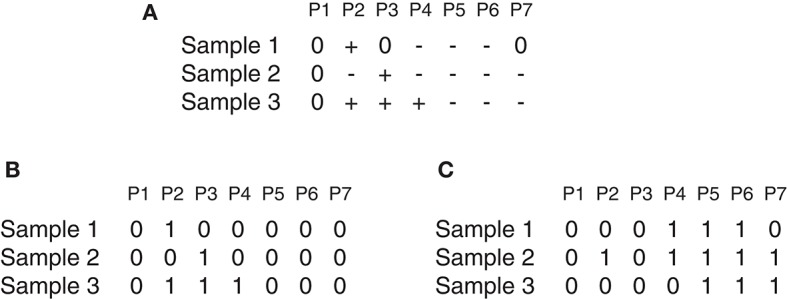
GAIA illustrative example. (A) Represent an example of matrix A, where + denotes gain, − denotes loss and 0 denotes no alteration. (A) Contain two homogeneous regions from probes P4 to P6 for samples S1 and S2 and from probes P5 to P7 for samples S2 and S3. (B,C) Show the matrices AL and AD determined of the matrix in (A).